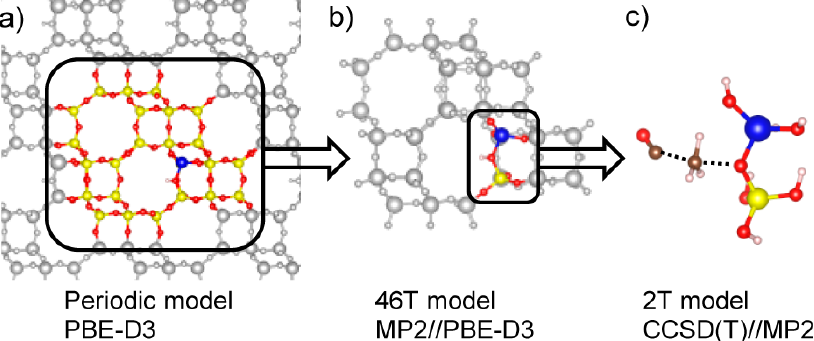
Figure 4. Models of a high silica zeolite with the chabazite (CHA) topology (H-SSZ-13); ( a ) periodic model with DFT Perdew–Burke–Ernzerhof (PBE)-D3 method, ( b ) 46 atomic cluster model with Møller – Plesset perturbation theory (MP2)/PBE-D3 method, and ( c ) 2T cluster model with coupled-cluster method (CCSD)(T)/MP2 method, where T abbreviates the SiO 4 tetrahedron, which is a basic unit of zeolites. Reprinted with permission from [41]. Copyright (2017) American Chemical Society.